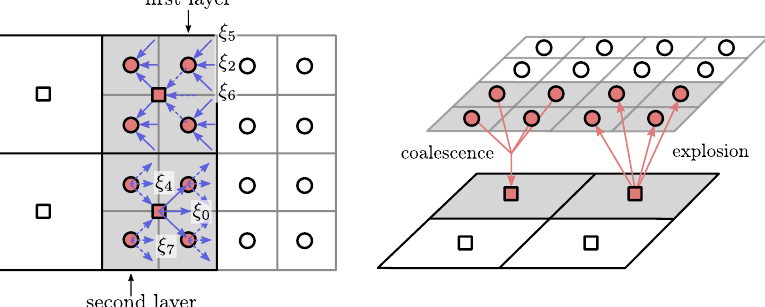
Figure 5. Grid transition interface for two-dimensional cell-centered layout, : Regular fine node, : Fine interface node, : Regular coarse node, : Coarse interface node, inward pointing arrows { ξ } represent directions of pre-collision populations averaged and assigned to during 2 , ξ 5 , ξ 6 coalescence , outward pointing arrows { ξ 0 , ξ 4 , ξ 7 } represent directions of post-collision populations distributed among during explosion . Solid arrows show populations provided, dashed arrows populations